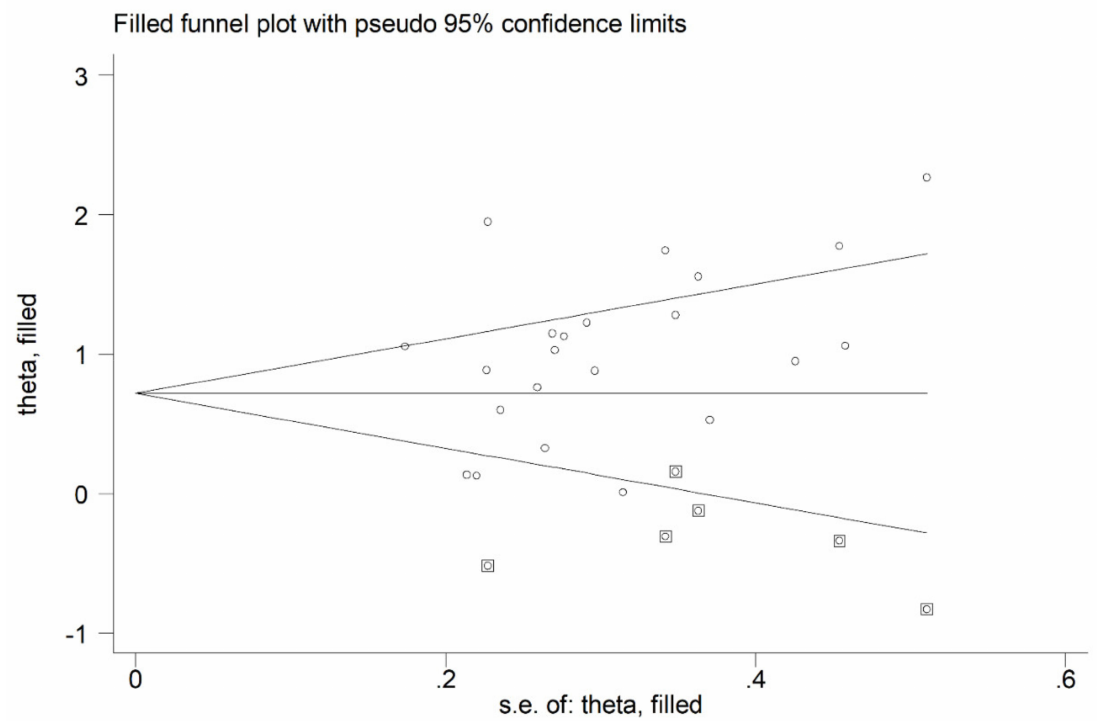
Figure 5. Funnel plot of studies investigating MDA concentrations in OSA after trimming and filling. Dummy studies and genuine studies are represented by enclosed circles and free circles,